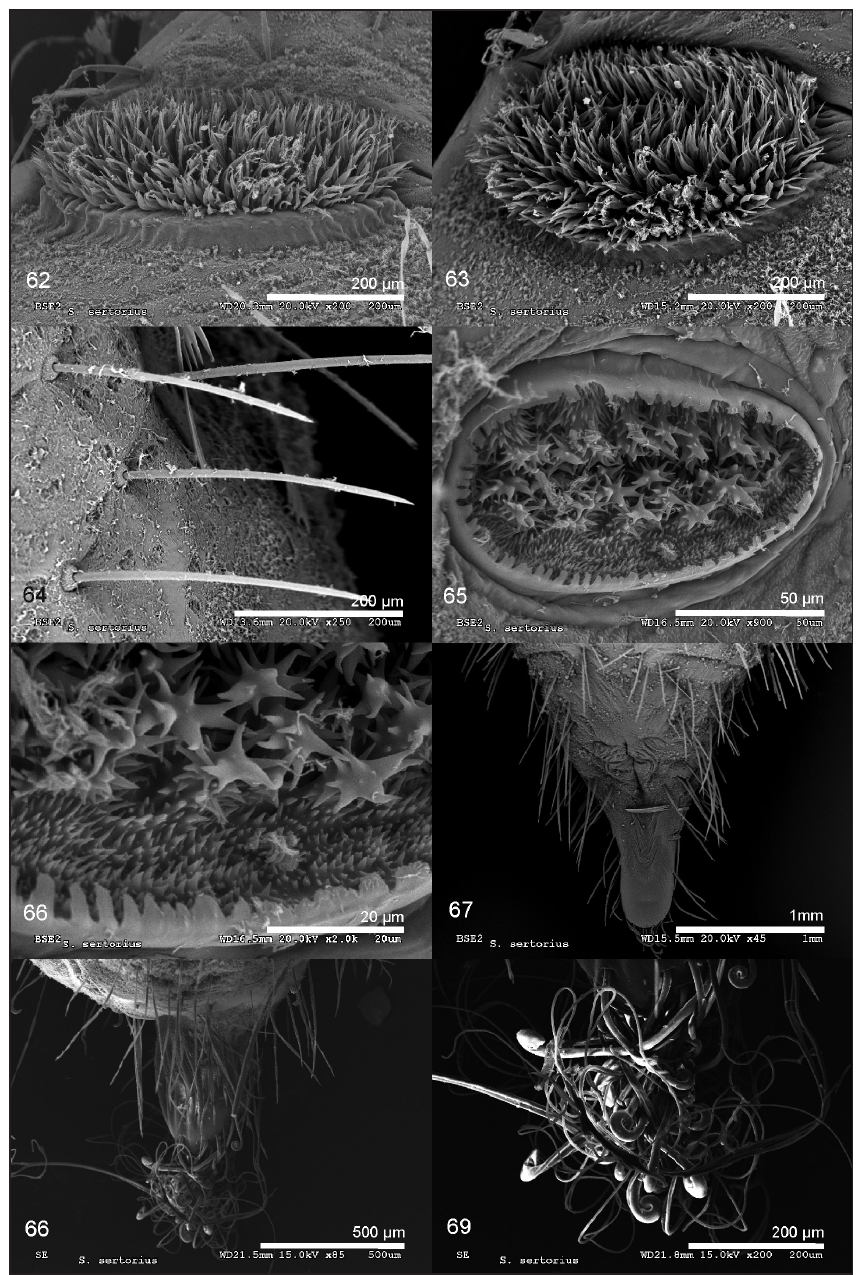
Figures 62–69. Scanning electron microscope images of a pupa of Spialia sertorius from Losar de la Vera, Cáceres, Central Spain. 62. Lateral view of the mesothoracic tubercle. 63. Upper view of the mesothoracic tubercle. 64. Detail of the pupal cuticle showing smooth setae with rounded bases. 65. Abdominal spiracle. 66. Detail of the spiny papillae inside the spiracle. 67. Ventral view of the last abdominal segments. 68. Detail of the cremaster 69. Detail of the cremastral